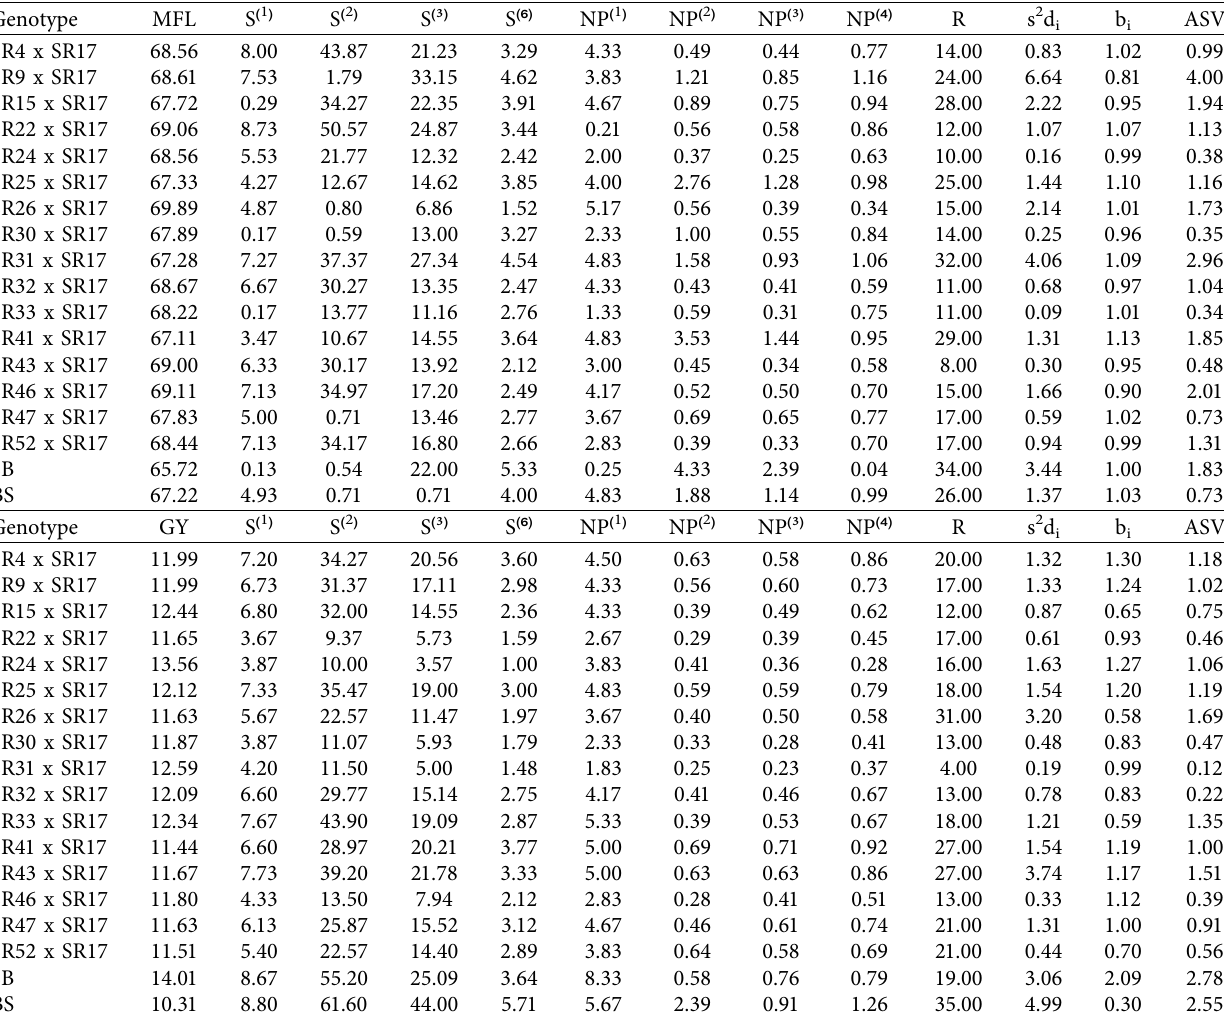
Table 3: Stability of earliness and yield based on nonparametric and parametric